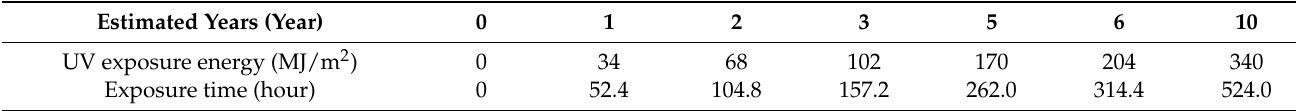
Table 2. Conditions to prepare UV-exposed yarn specimens.